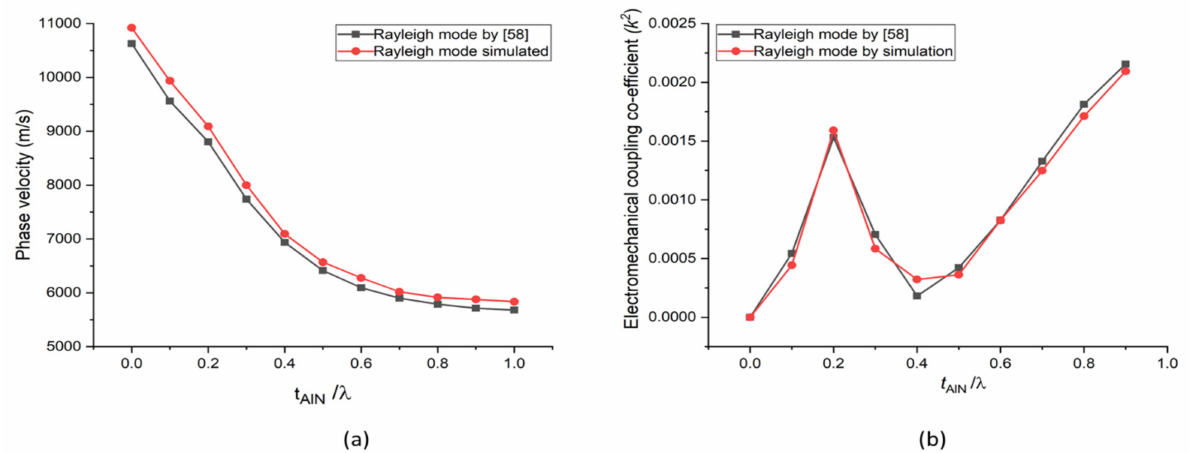
Figure 3. Simulated results of AlN/Diamond structure ( a ) phase velocity (Rayleigh mode) versus normalised thickness of AlN ( b ) k 2 (Rayleigh mode) versus normalised thickness of